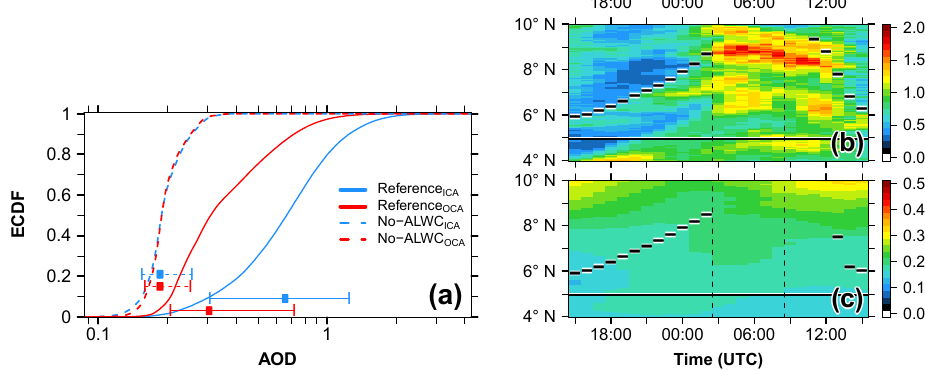
Figure 12. (a) ECDF of the total AOD of ICA (blue) and OCA (red) for the reference (solid lines) and No-ALWC (dashed lines) over the Ivory Coast (7.5–3 ◦ W, 4–10 ◦ N) including the time period from 2 July 15:00UTC to 3 July 15:00UTC. The dots (circles) highlight the median with respect to the reference (No-ALWC) and the whiskers the 10th and 90th percentiles; Hovmöller diagrams of AOD for (b) the reference and (c) No-ALWC as a zonal mean over the respective area. The horizontal bars denote the zonal mean location of the 302K isentrope at 250ma.g.l., the horizontal solid line the zonal mean coastline and the vertical dashed lines the three phases introduced in Fig. 3. Note the different color scales in (b) and (c)